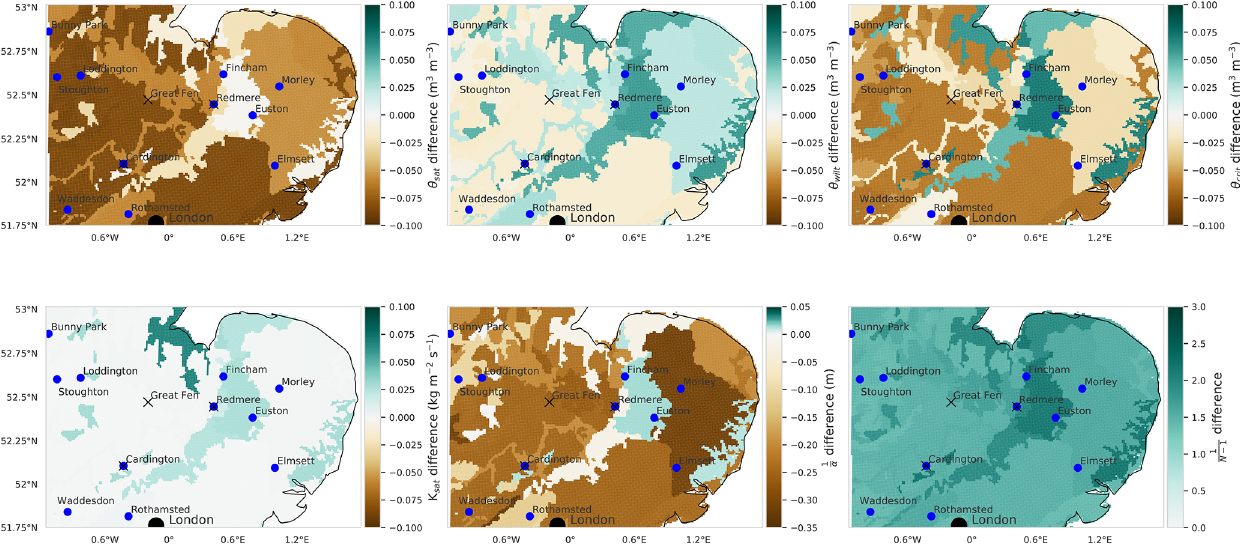
Figure 5. Maps showing the difference between the prior and posterior mean JULES model soil parameters, created by applying the prior and posterior PTFs to the HWSD maps of soil properties. Brown corresponds to a decrease in the soil parameter after data assimilation and green to an